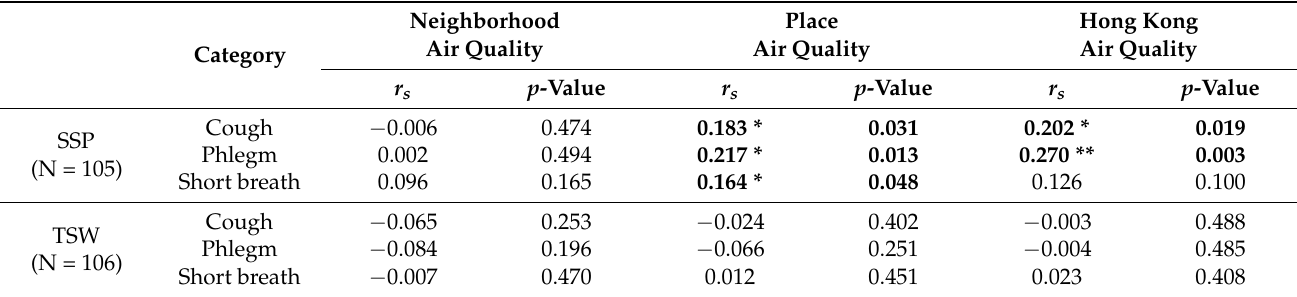
Table 7. The Spearman rank correlation coefficients in SSP and